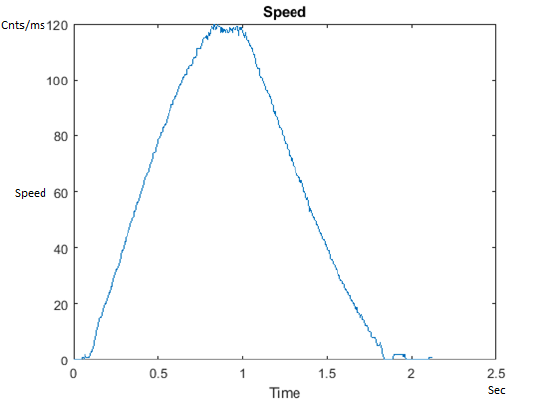
Figure 4. Speed graph of a typical run with PID++ motion